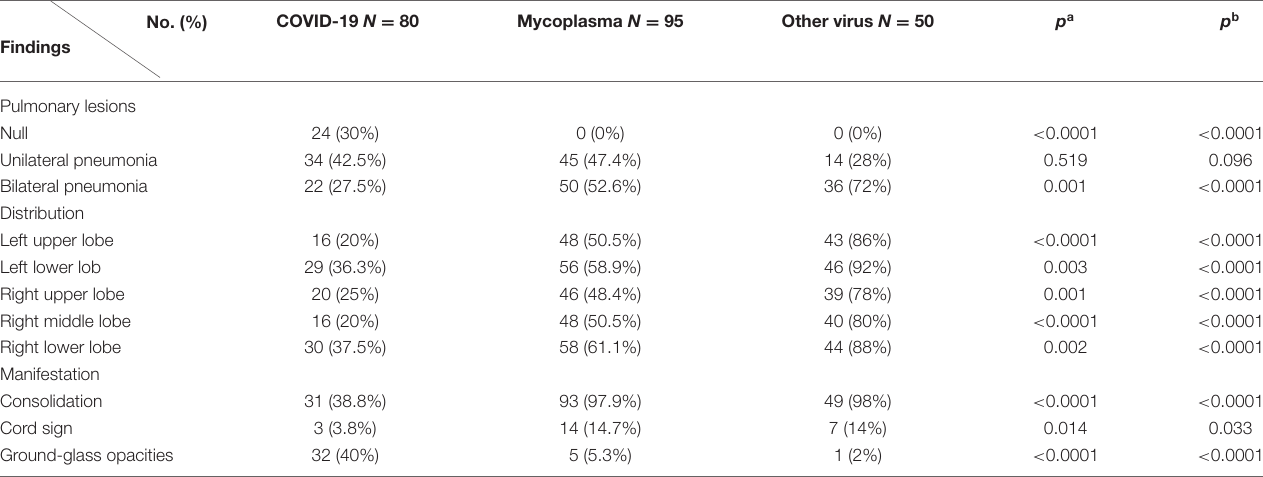
TABLE 3 | CT imaging findings in pediatric